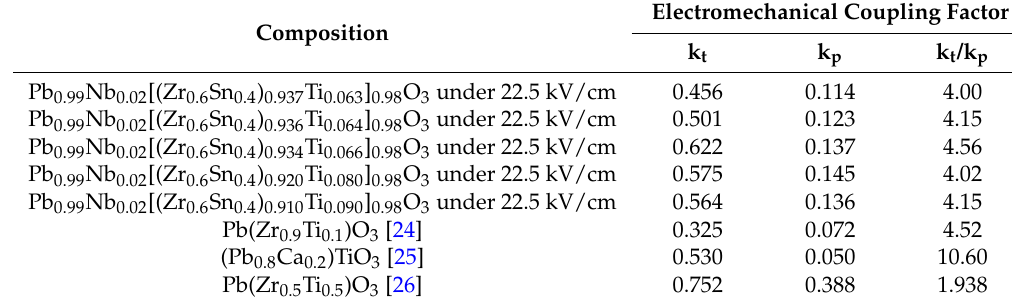
Table 1. Anisotropic piezoelectric constants in field-biased PNZST, PbZrO 3 - and PbTiO 3 -based ceramics.